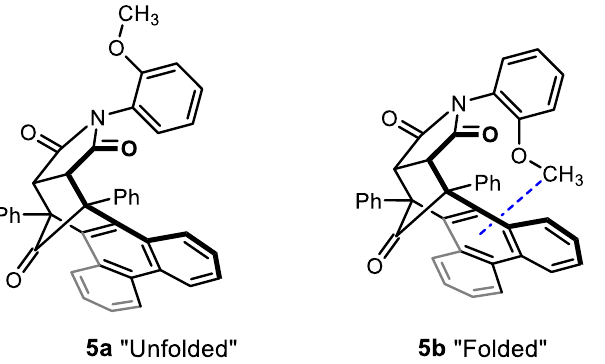
Figure 1. “ U nfolded” and “folded” conformers of maleimide 5 (the CH –π interaction is indicated Figure 1. “Unfolded” and “folded” conformers of maleimide 5 (the CH– π interaction is indicated on on 5b as a dashed line). 5b as a dashed